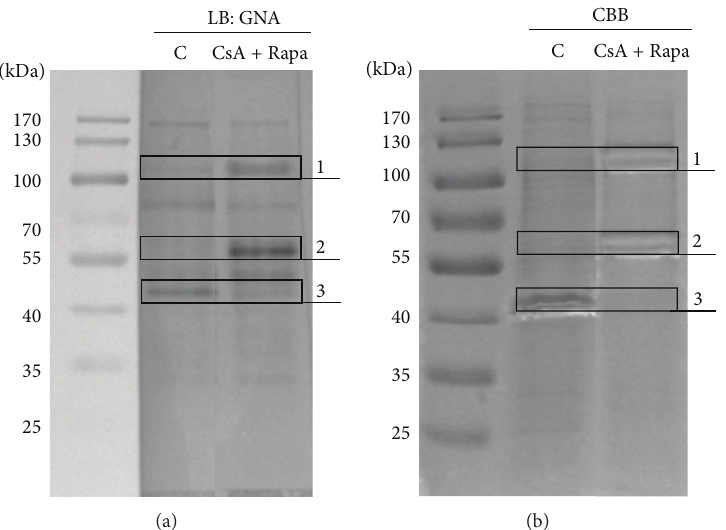
Figure 2: Immunosuppressive drugs change the intensity of bands containing GNA-positive proteins. Peripheral blood mononuclear cells were cultured for 6 days in the presence of the combination of CsA (150ng per 1mL medium) and Rapa (12ng per 1mL medium) in a two-way mixed leukocyte reaction (MLR) and then lysed in RIPA buffer. Whole-cell lysate proteins (500 𝜇 g) were precipitated with 25 𝜇 L agarose-bound Galanthus nivalis lectin (GNA). The captured glycoproteins were recovered by boiling in Laemmli sample buffer with 𝛽 -ME andresolvedby10%SDS-PAGEunderreducingconditions.One-fifthoftheGNAprecipitatewasdestinedforWesternblotting(WB)andafter probing with biotinylated-GNA was visualized by AP colorimetric reaction (a). The remaining four-fifths of the precipitate, after resolving on the same gel, were stained with Coomassie Brilliant Blue (CBB) and the bands were excised for MS/MS analysis (b). Molecular weight of proteins was assigned using a PageRuler Prestained Protein Ladder (Thermo Scientific, 26616). LP: lectin precipitation, C: untreated cells, CsA: cyclosporin A, and Rapa: